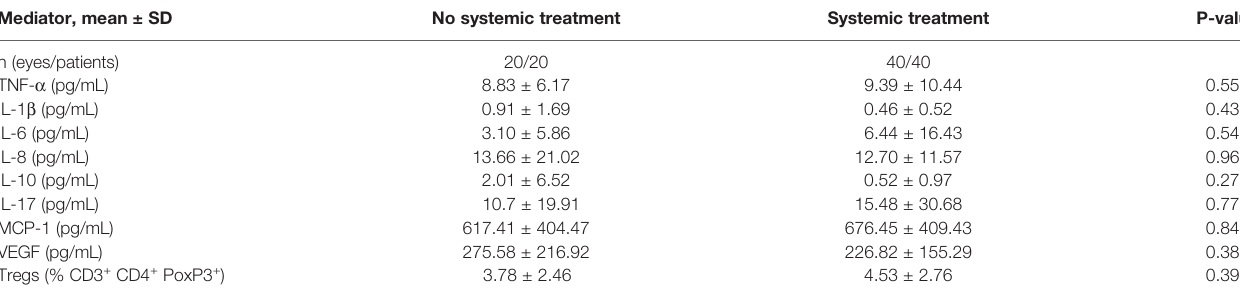
TABLE 2 | In fl ammatory mediators in patients with or without systemic treatment at baseline. Mediator, mean ± SD No systemic treatment Systemic